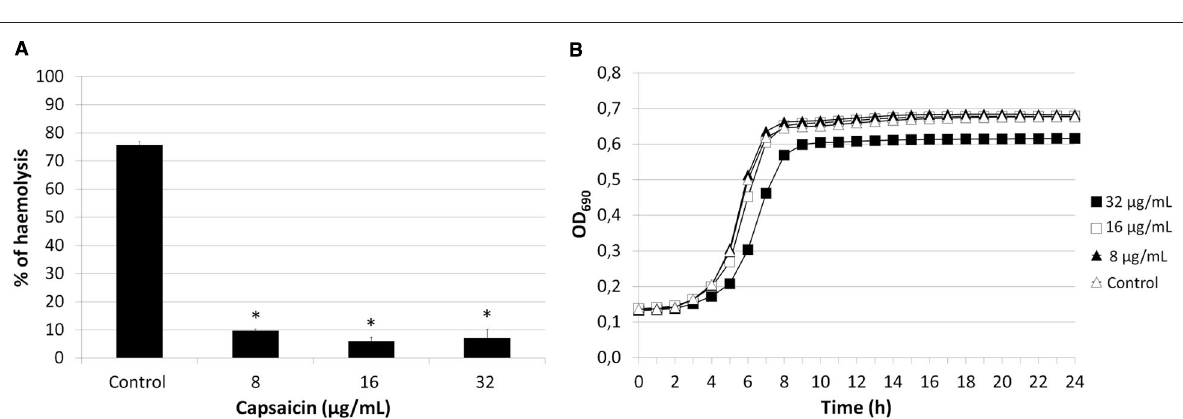
FIGURE 4 | Haemolytic activity and growth of strain SP1070 in presence of capsaicin sub-MICs. (A) Percent haemolysis of SP1070 supernatants. Results are the mean (cid:6) SD of three experiments. Asterisks denote significant values with respect to the control ( p (cid:20) 0.05). (B) Time-kill curve of SP1070 in presence of capsaicin